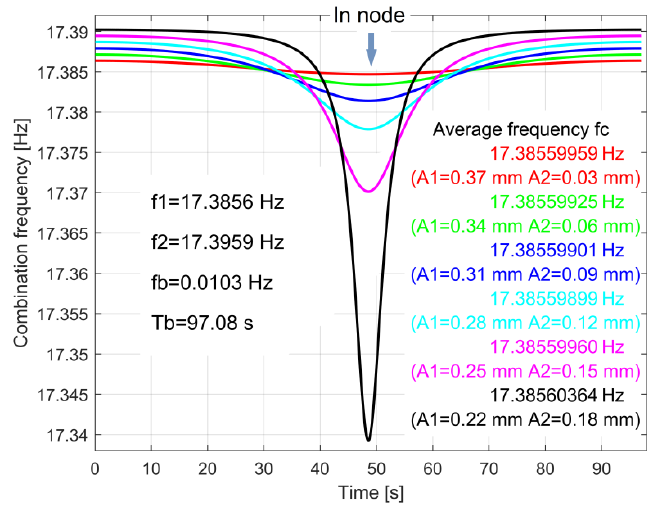
Figure 10. The evolution of the instantaneous combination frequency on simulated vibration beating during a beat period (the same condition as in Figure 9, except for the amplitudes relationship: A 1 > A 2 ).